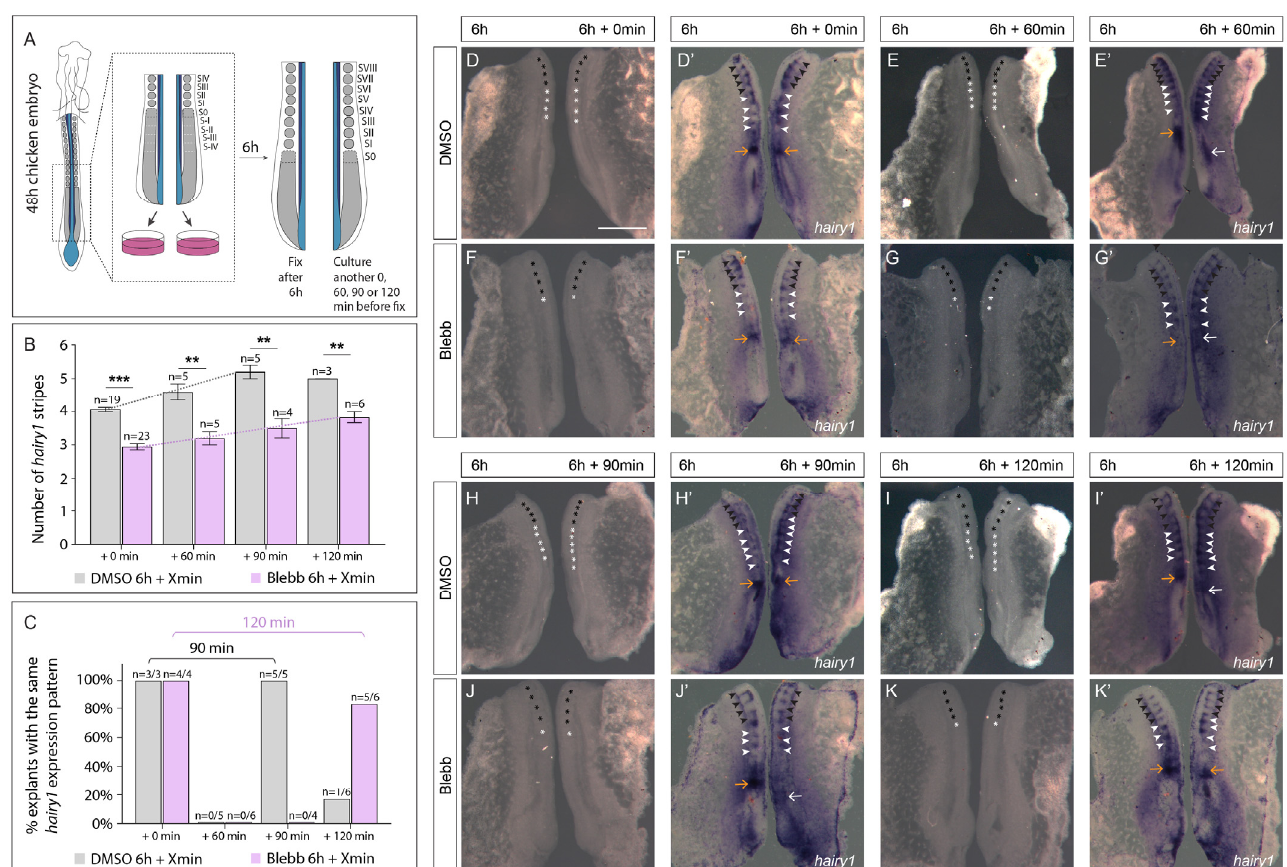
Figure 7. hairy1 expression oscillates with a periodicity of 120 min in explants cultured with Blebbistatin. ( A ) Experimental setup: posterior embryo halves were cultured separately in the same conditions. After 6 h, one of the explants was fixed and the other one was either fixed at the same time (0 min) or cultured for another 60, 90 or 120 min. ( B ) Number of hairy1 expression stripes observed after different incubation periods. Explants cultured with Blebbistatin form significantly fewer hairy1 expression stripes. ( C ) Percentage of explant pairs showing the same hairy1 expression pattern in different time intervals. ( D – K’ ) Dorsal views of representative examples of explant pairs cultured in DMSO ( D – E’ , H – I’ ) or Blebbistatin ( F – G’ , J – K’ ). Each explant pair was imaged twice: prior to hairy1 probe addition ( D – K ) and after in situ hybridization staining ( D’ – K’ ). Black and white asterisks indicate visible somitic structures before and after culture, respectively. Black arrowheads mark molecular segments characterized by hairy1 expression stripes formed before culture, white arrowheads are stripes of hairy1 expression formed during culture. Same colour arrows indicate the same hairy1 expression pattern in contralateral PSMs, while arrows with different colours indicate different expression patterns. Rostral to the top. p values were calculated using a Kruskal–Wallis test. Error bars in B indicate standard error of the mean. See also: data in Table S1. Blebb—Blebbistatin. *** p < 0.001; ** p < 0.01. Scale bars: 500 µm.